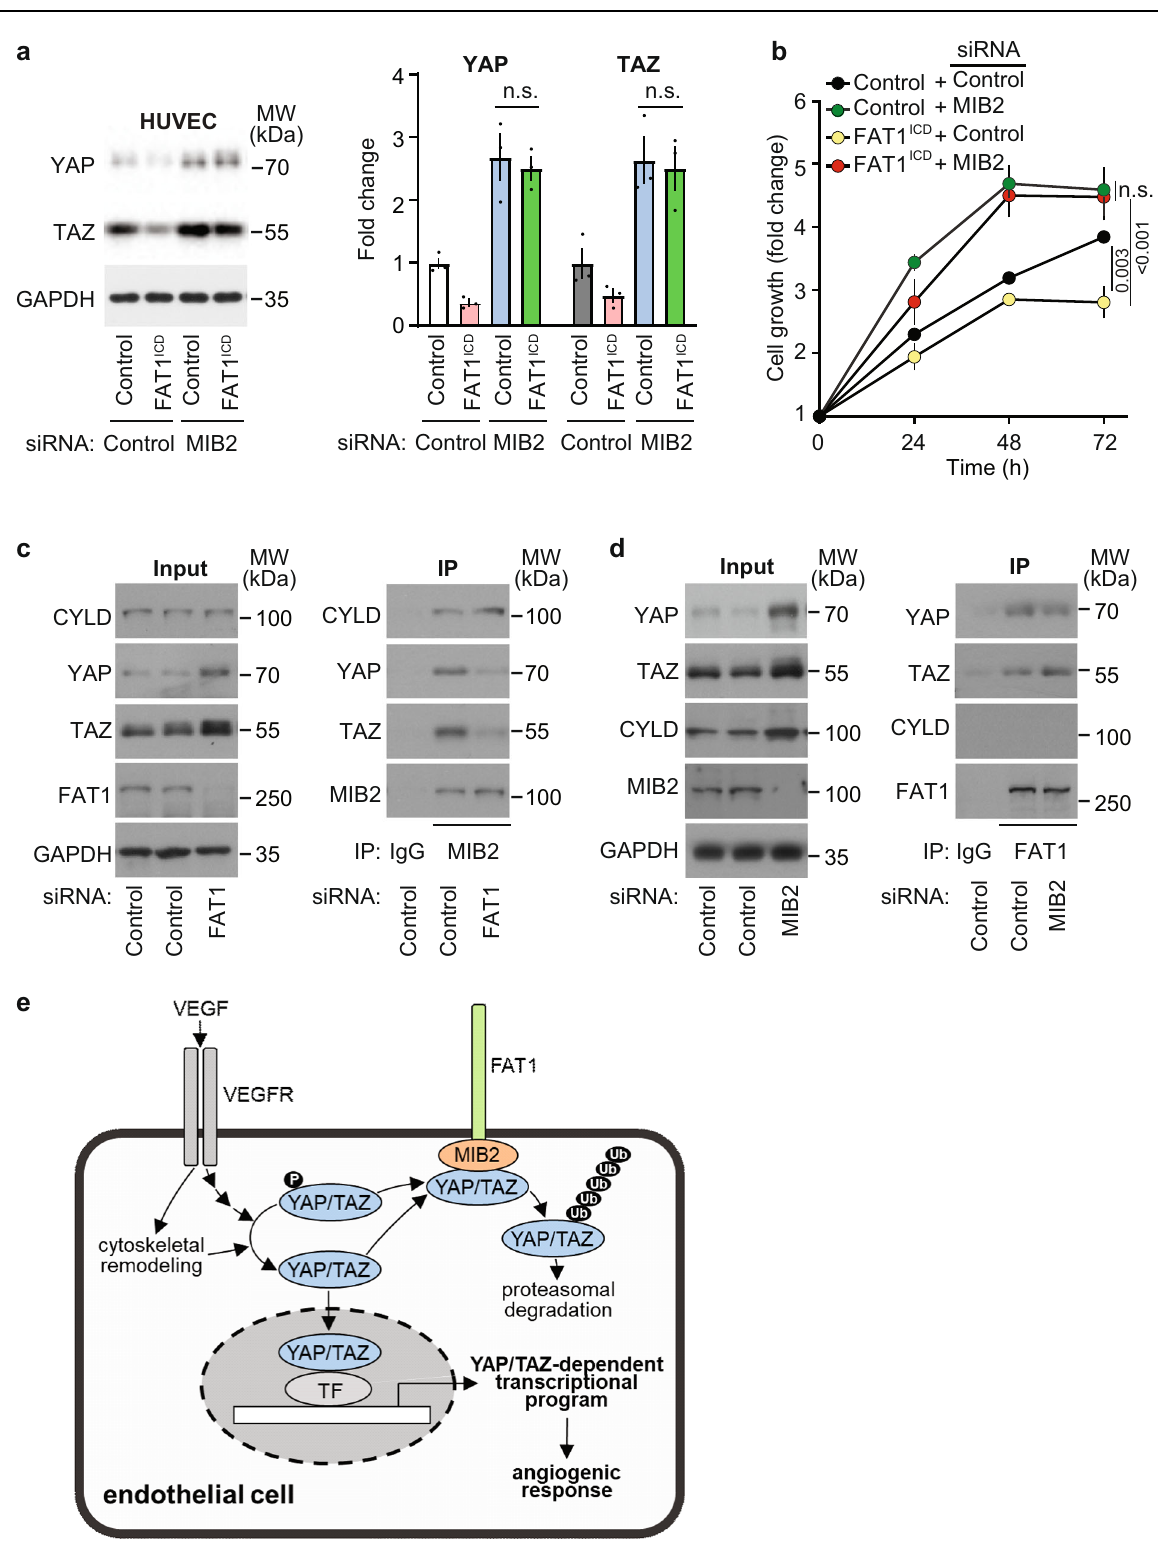
00124477), 5-GATGAATCAGCCTCTGAAT-3. Western blotting Cellsweredirectlylysedin1 ×Laemmlibuffercontaining150mMNaCl, 50 mM Tris-HCl (pH6.8),2.5mMEDTA, 1%(w/v) SDS, 5%glycerol, 1% β - mercaptoethanol, 5% (w/v) bromophenol blue. Total cell lysates were